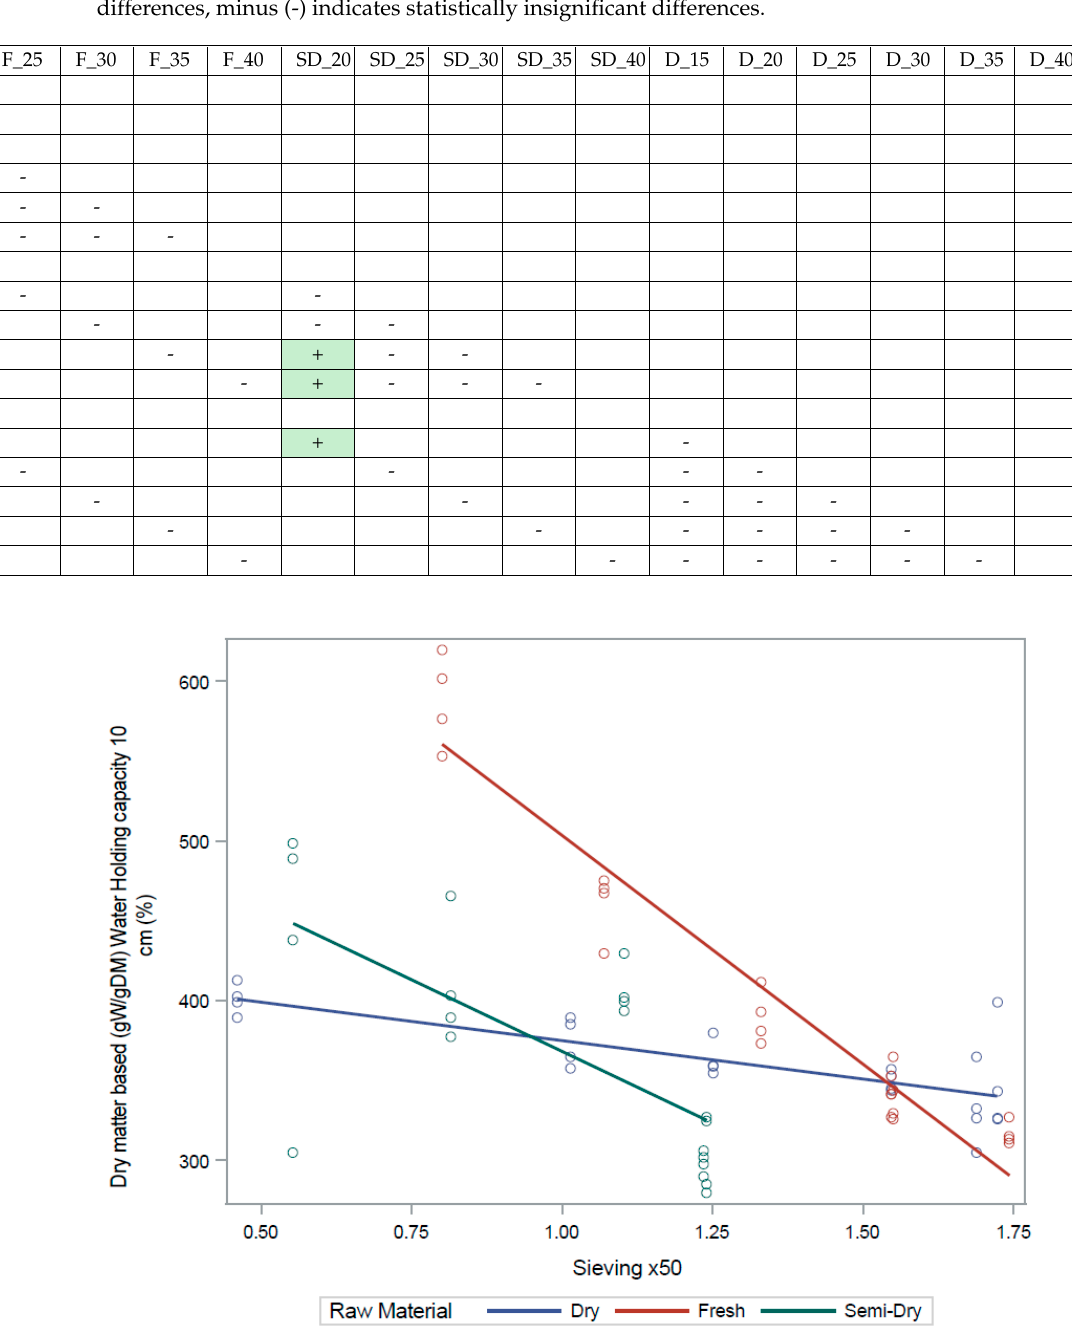
Figure A1. Correlation between WHC − 1 kPa (dry matter based) and X-50.